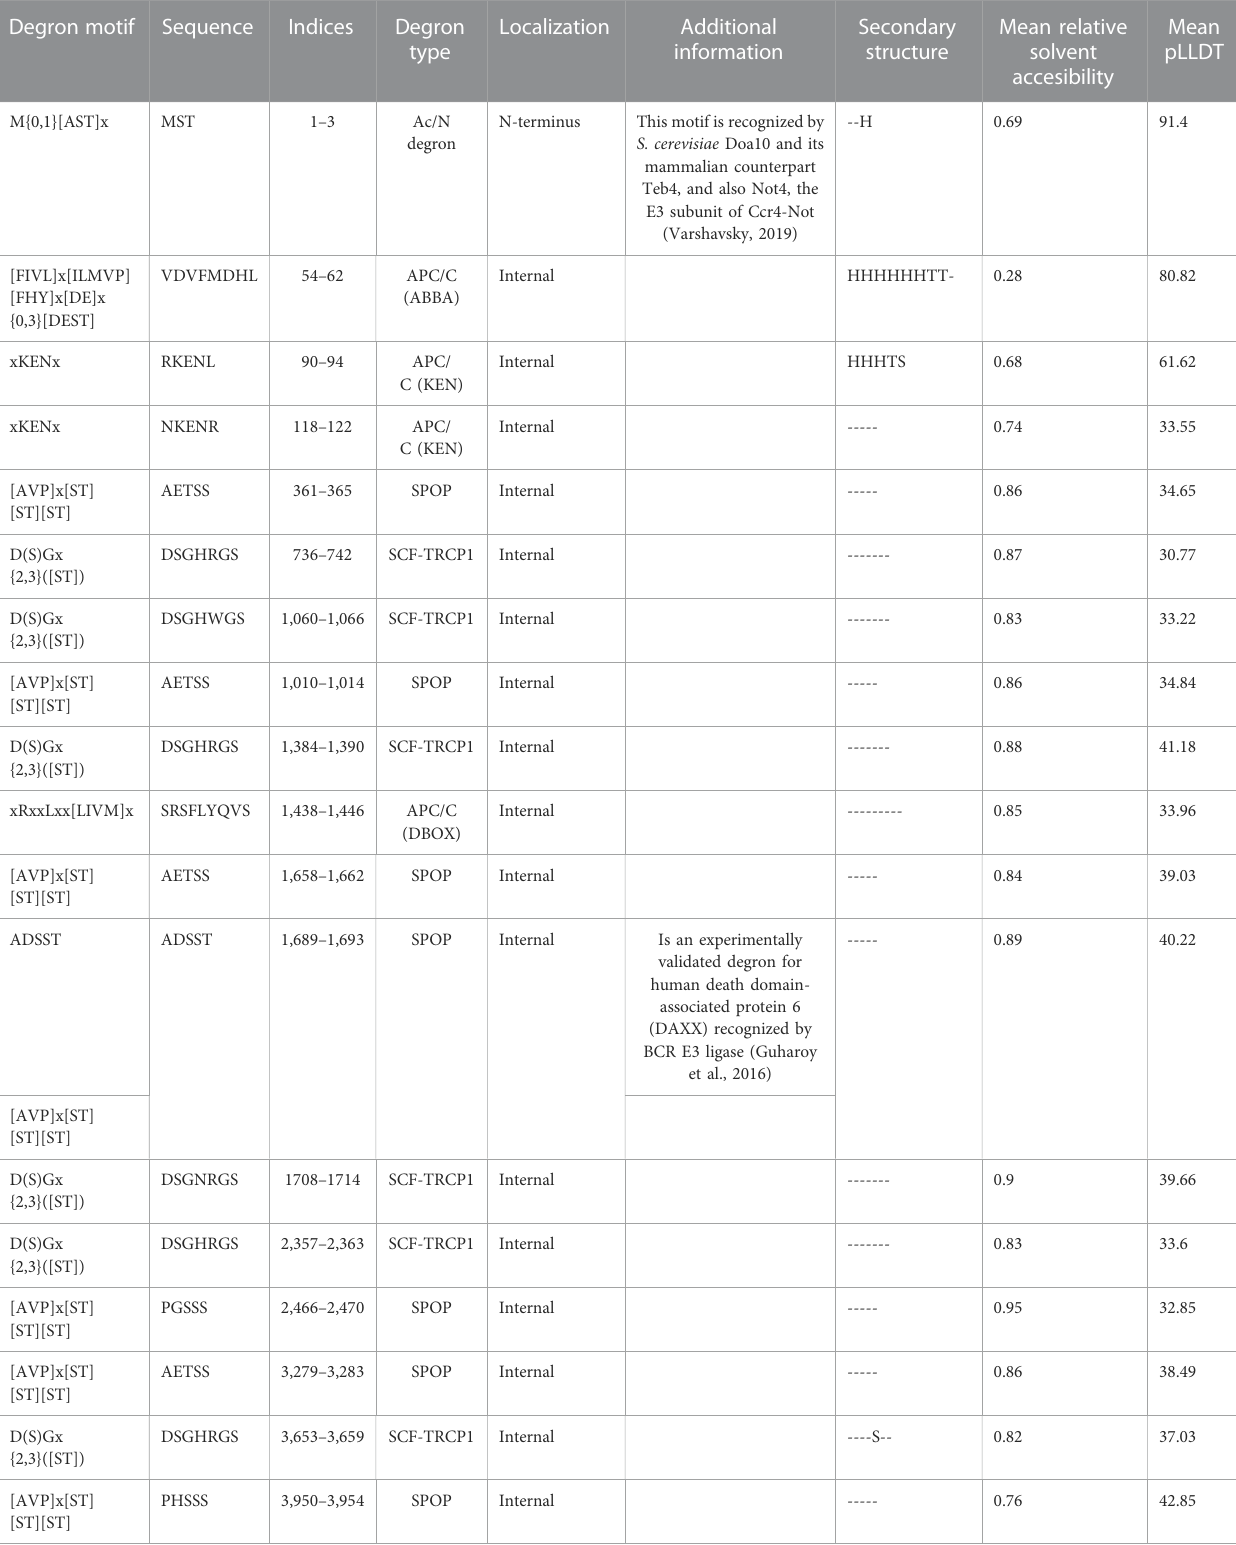
TABLE 1 List of degron motif, type and location in the pro fi laggrin protein sequence. Degron